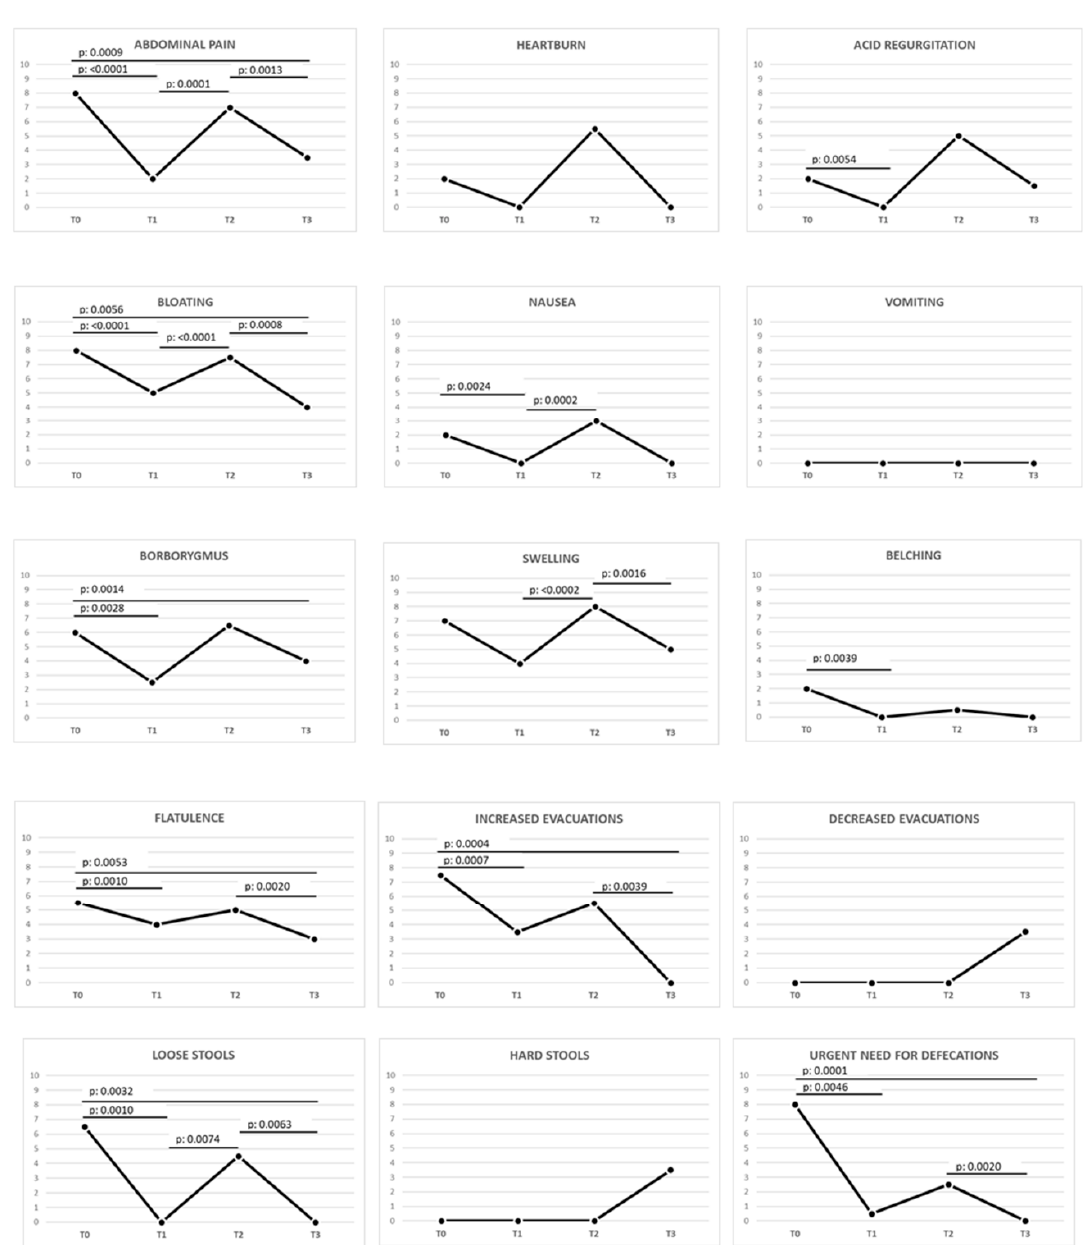
Figure 4. Variation of gastrointestinal symptoms in celiac patients during di ff erent stages of the study. The p -value was calculated using the Wilcoxon signed-rank test (statistically significant p -value <